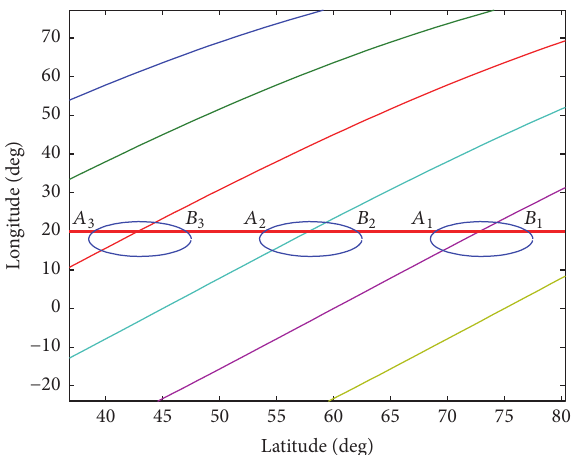
Figure 3: Satellite coverage of the same latitude stripe in different orbital